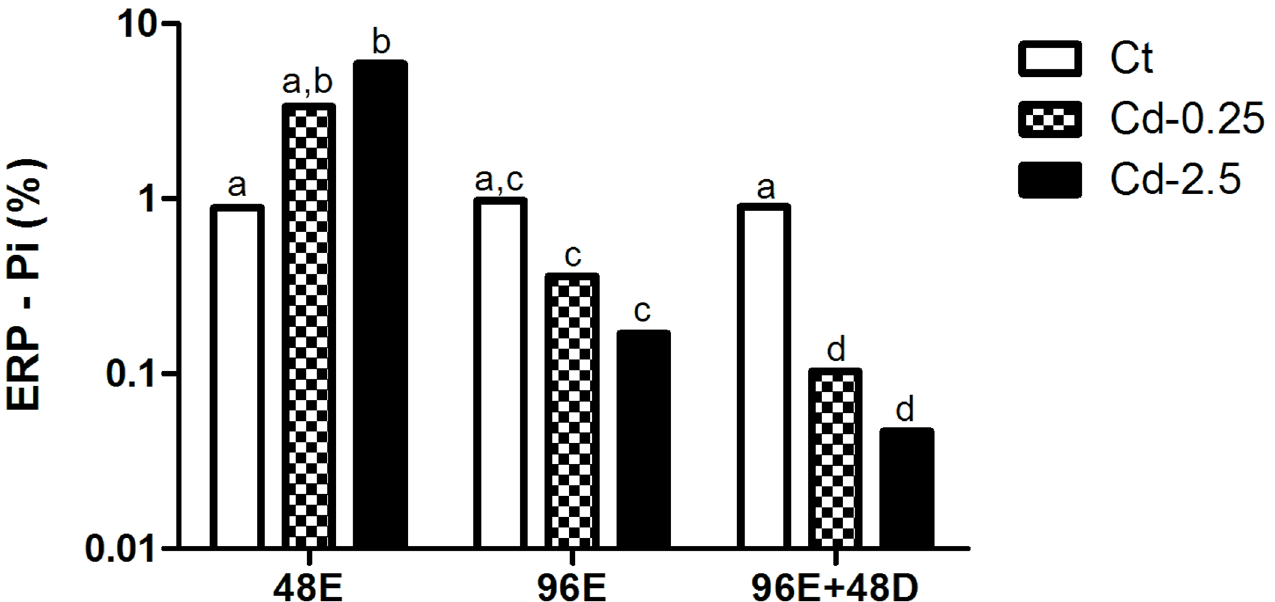
Fig 4. Percentage of erythrocytes labeled by PI in in vivo assay. Values followed by different letters differ by Mann-Whitney test (p < 0.05).